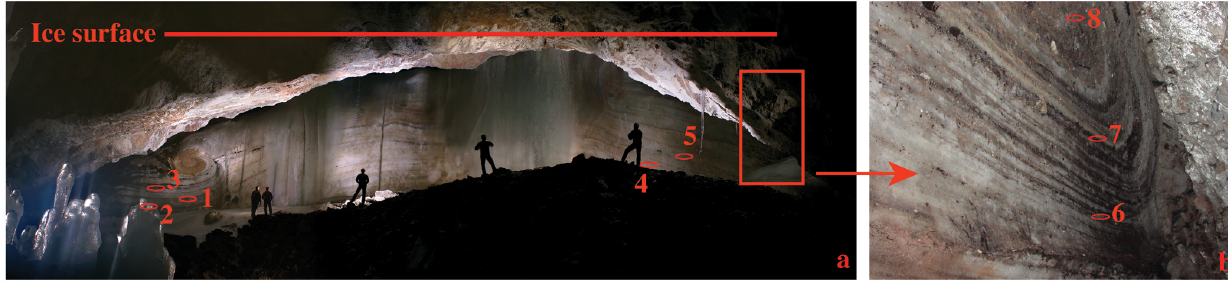
Fig. 3. The exposed wall of the ice block as seen from the Little Reservation, with the position of radiocarbon ages shown.